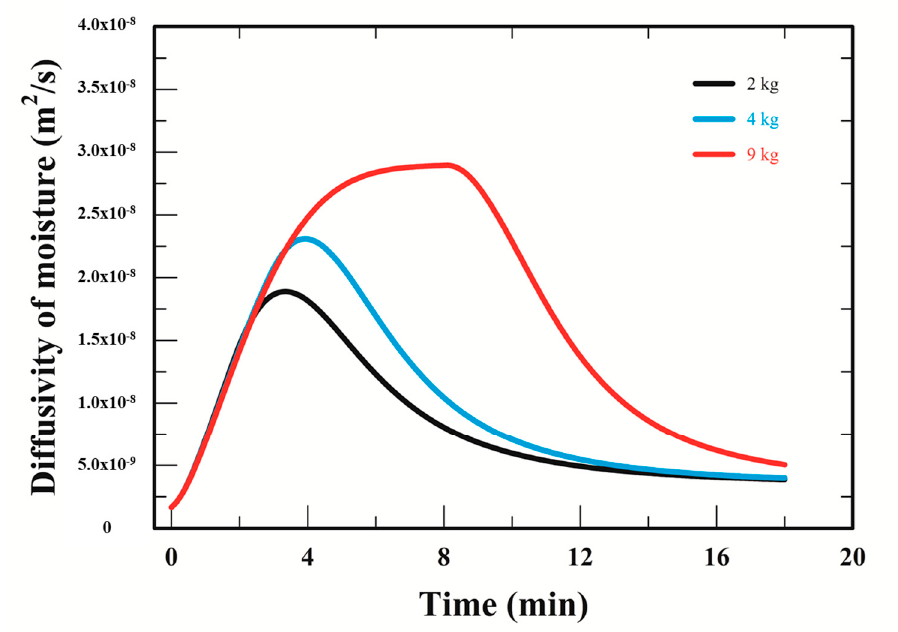
Figure 7. Simulated results of the change in the di ff usivity of moisture during drying with di ff erent loadings, from 2 to 9 kg, at 120 ◦